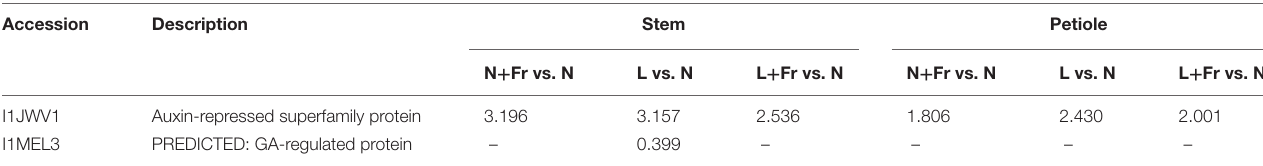
TABLE 3 | Differentially expressed proteins in the stems and petioles that were associated with auxin and GA regulation under different light intensity and quality treatments identified by TMT with LC-ESI-MS-MS/MS. Accession Description